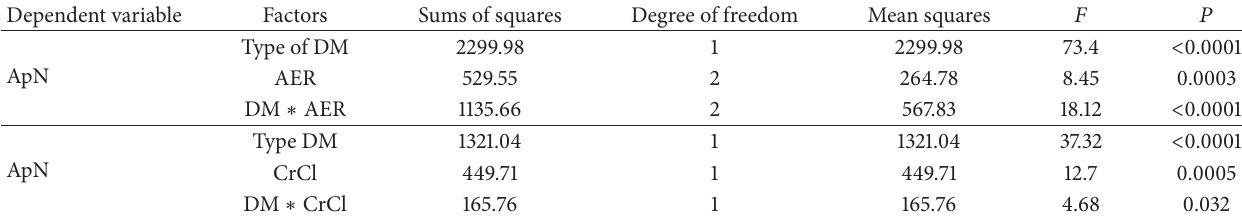
Table 2: Results of ANOVA for ApN as dependent variables according to AER, type of diabetes, CrCl, and their interactions.